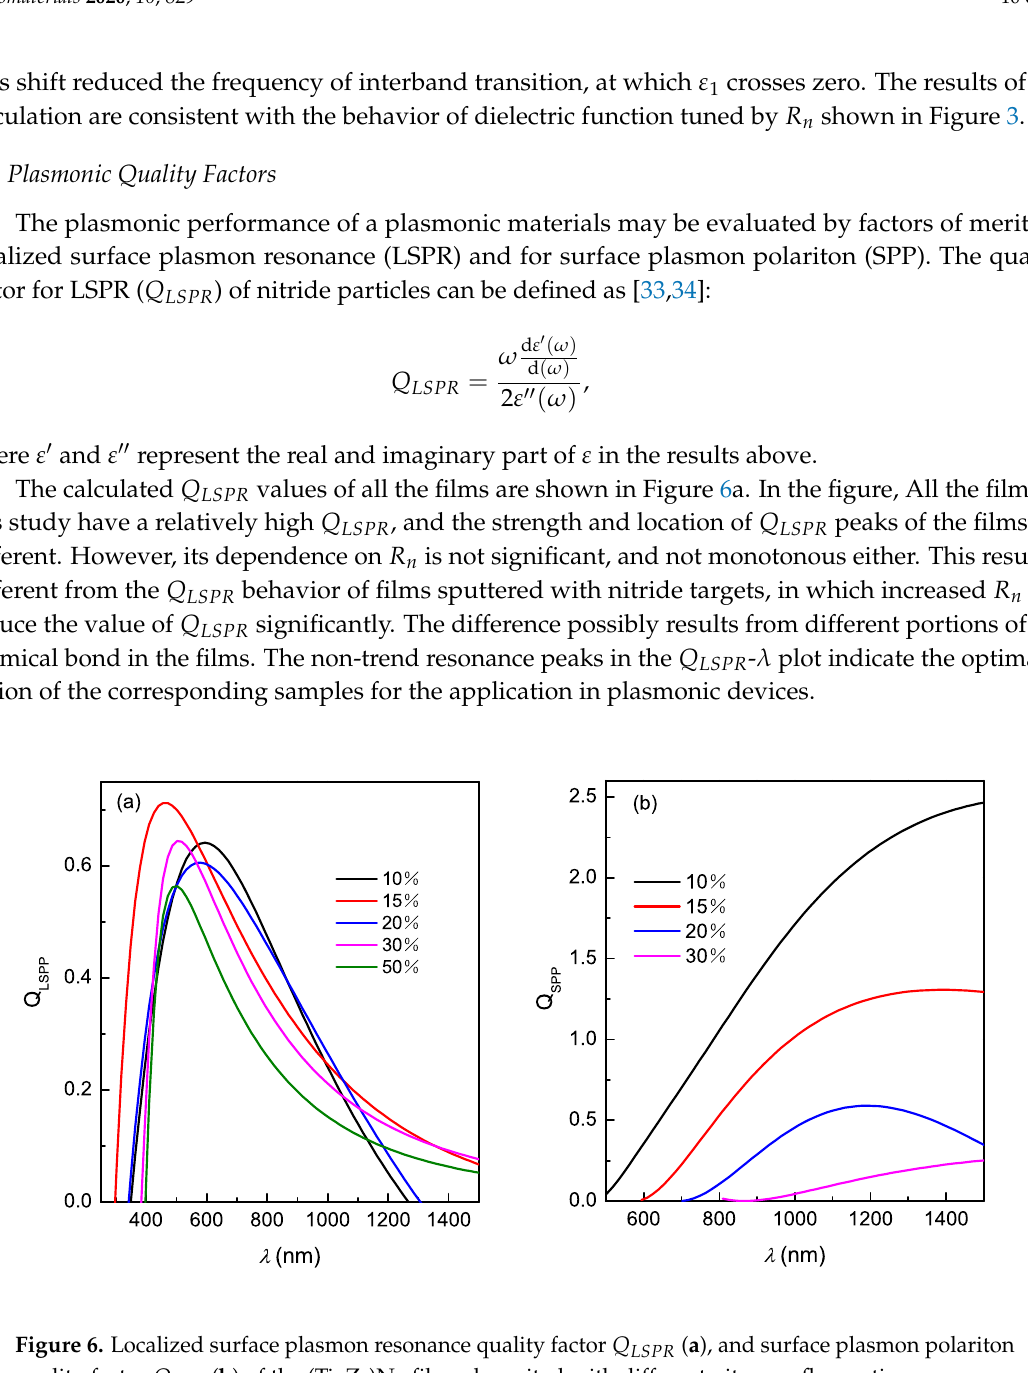
Figure 6. Localized surface plasmon resonance quality factor Q LSPR ( a ), and surface plasmon polariton quality factor Q SPP ( b ) of the (Ti, Zr)N x films deposited with different nitrogen flow